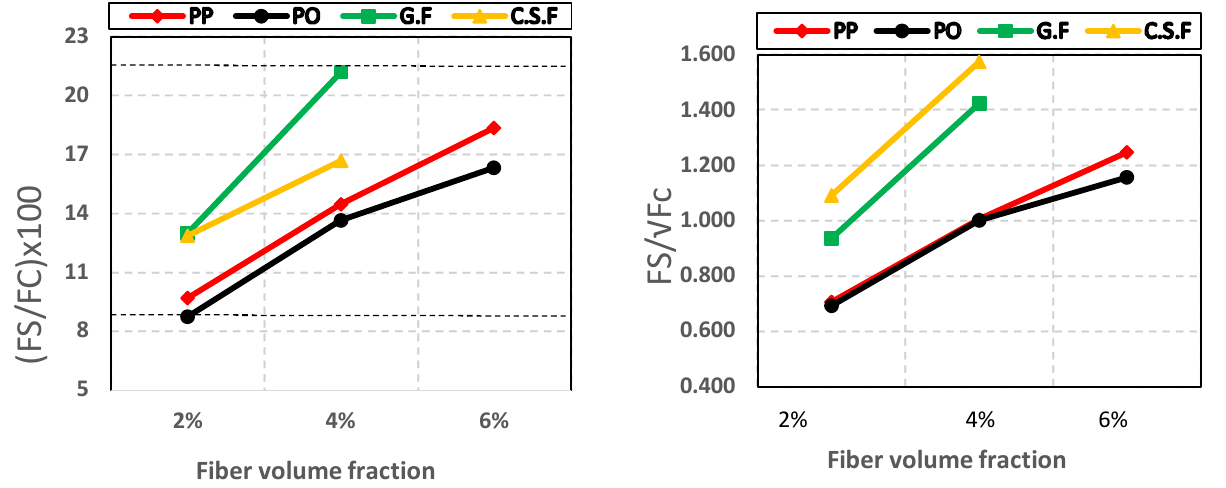
Figure 21. Relationship between flexural strength and compressive strength of FRC and ECC specimens.